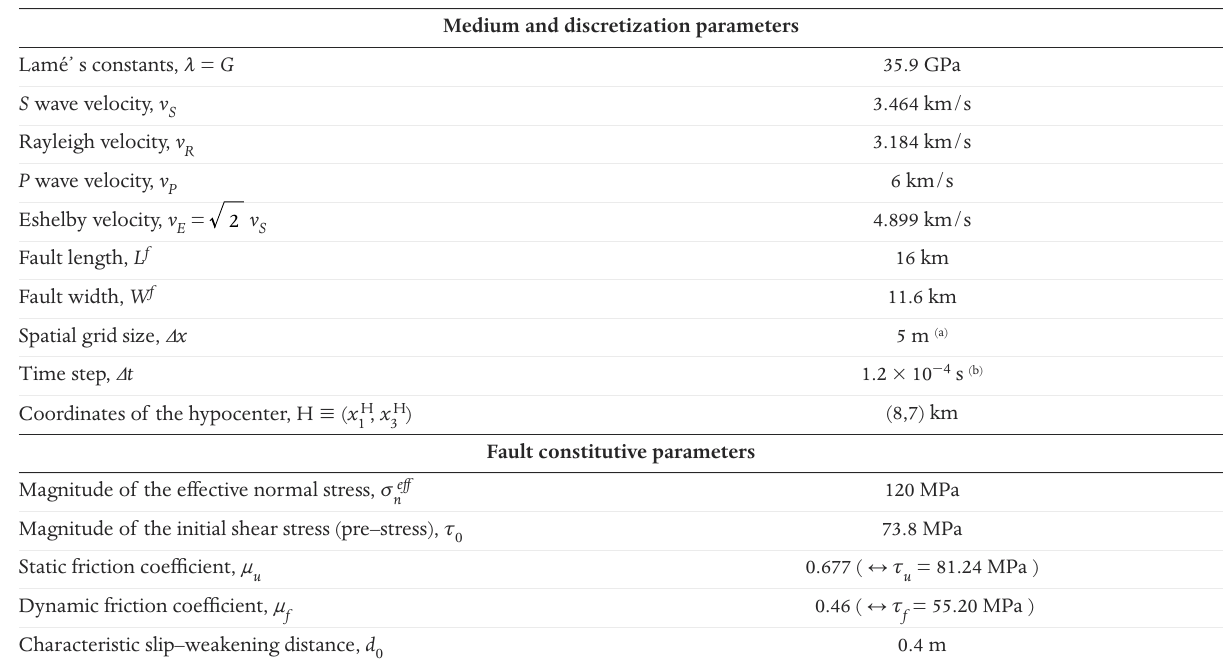
). b D t / D x , equals v CFL S df ( s ) = v /(6 D x ), acc S P